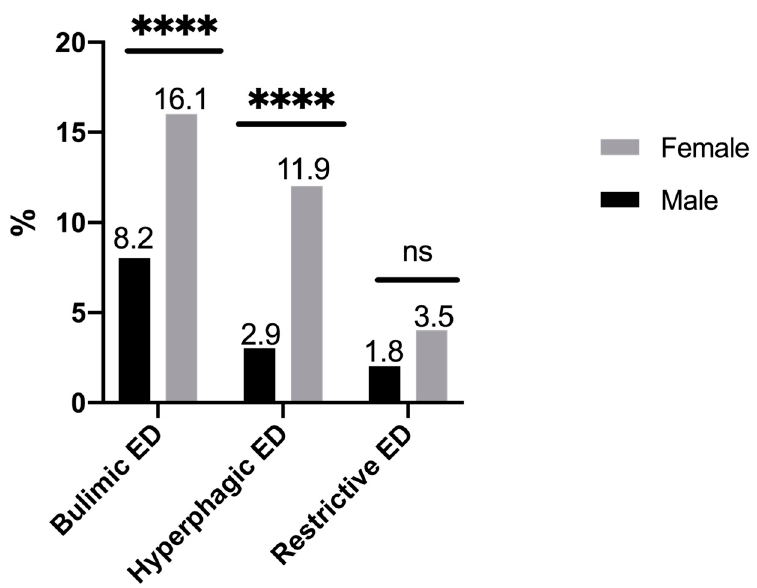
Figure 1. Prevalence of bulimic, hyperphagic, and restrictive eating disorders according to the gender of students ( n = 1493). ns: non significant. ****: p < 0.0001.